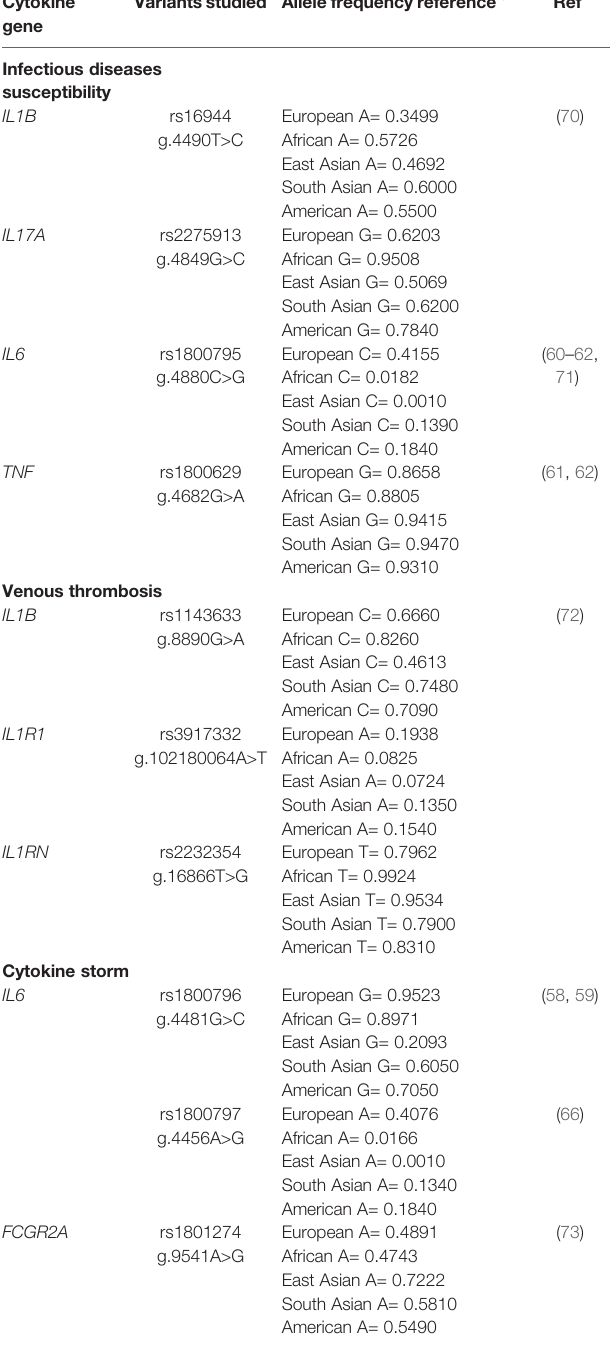
TABLE 2 | Frequency of allelic variants in cytokine genes associated with infectious disease susceptibility and COVID-19 manifestations. Cytokine Variantsstudied Allele frequency reference gene